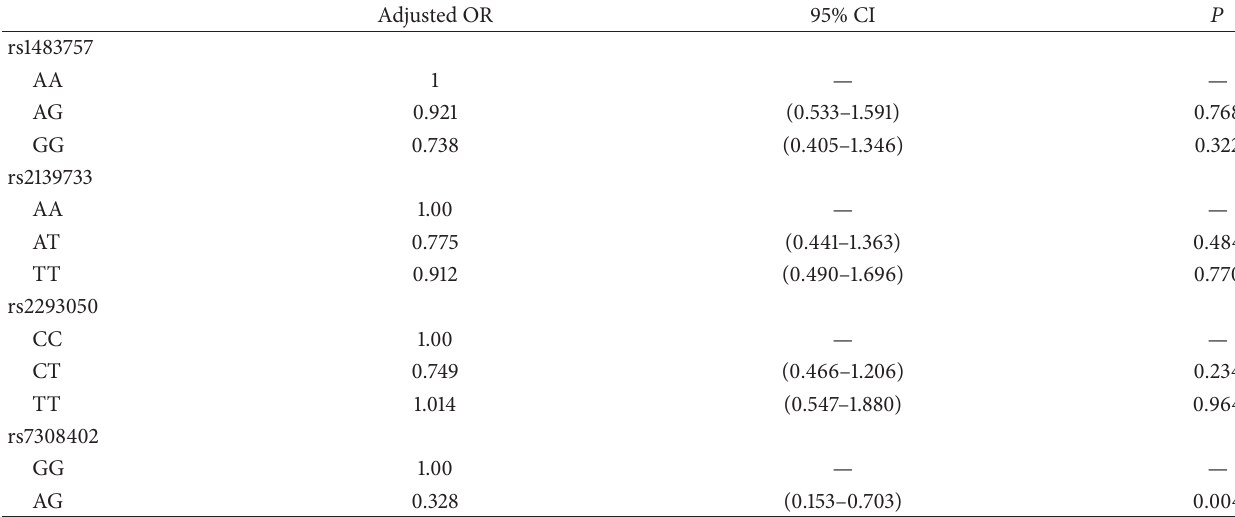
Table 4: Regression analysis in females n